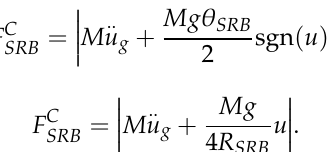
performance. control